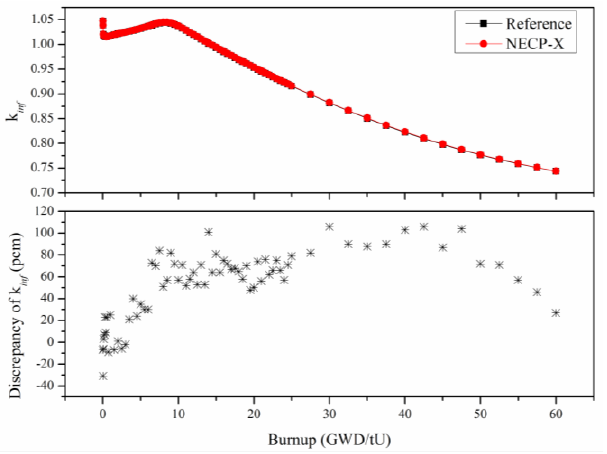
Figure 8. Comparison of k inf for VERA 2O problem.